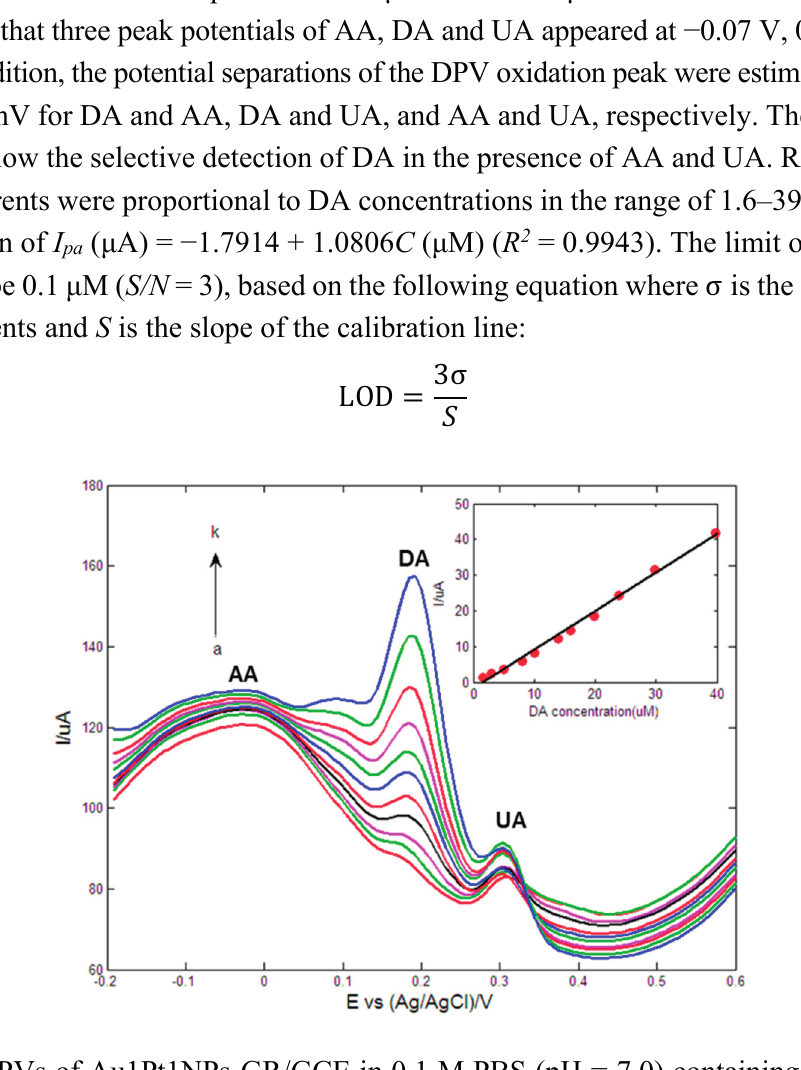
Figure 7. DPVs of Au1Pt1NPs-GR/GCE in 0.1 M PBS (pH = 7.0) containing 50 μ M AA, 12 μ M UA and different concentrations of DA (from a to k : 1.6, 3, 5, 8, 10, 14, 15.9, 19.9, 23.9, 29.8 and 39.7 μ M). Inset: The calibration curve of DA. Scan rate: 10 mV/s, pulse amplitude: 50 mV, pulse width: 40 ms, pulse period: 0.3